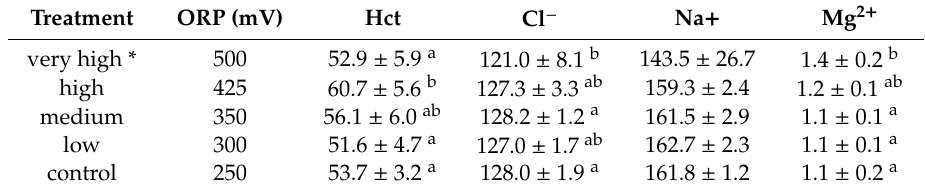
Table 1. Mean ( ± SD) hematocrit (Hct, n = 15) (%) and selected blood ion concentrations (Cl, Na, Mg, n = 6) (mmol L − 1 ) measured in Atlantic salmon post smolts exposed to 5 different ozone treatments (expressed as oxidation reduction potential (ORP) (mV)). * The very high (500 mV) treatment was sampled 5 days earlier.